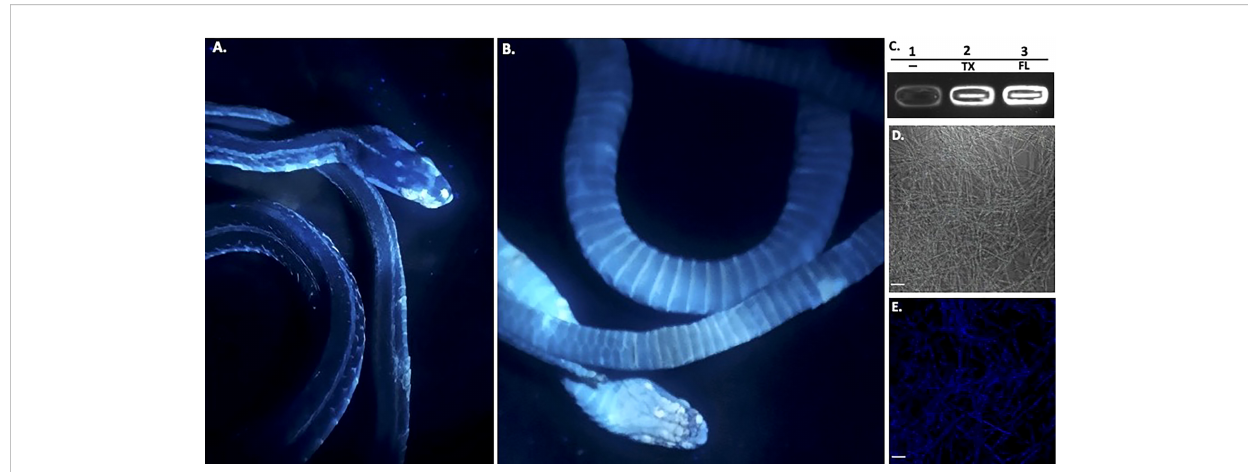
FIGURE 3 Ultraviolet Fluorescence. The infected deceased Western Ribbonsnake from Figure 2 under UV light (365nm) lamp, images shown are dorsal side (A) and ventral side (B) . Areas of intensity signal are evidence of the pathogen, O. ophiodiicola . (C) , Transilluminator readings of UV fl uorescence between strains O. ophidiicola FL (UAMH #10769) and O. ophidiicola TX. Lane 1, Buffer alone, lane 2, O. ophidiicola TX, Lane 3, O . ophidiicola FL. (D) , Confocal microscope imagery of O. ophidiicola TX in light phase and Texas found strain. (E) , UV fl uorescence after excitement at 358 nm and its emission at 460 nm (blue). Bars: (D, E) = 30 m